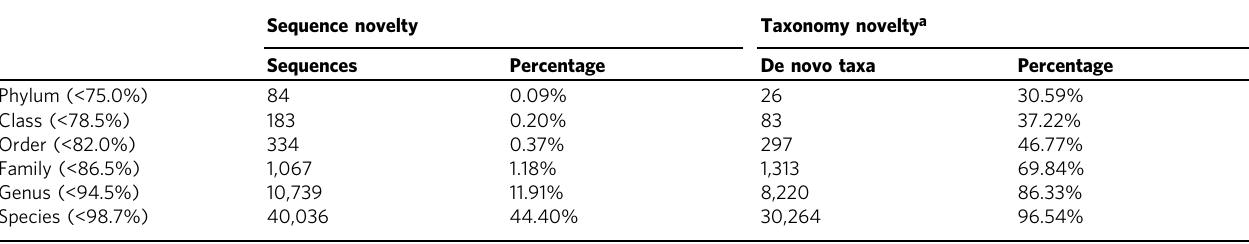
Table 1 Novel sequences and de novo taxa observed in the MiDAS 4 reference database.